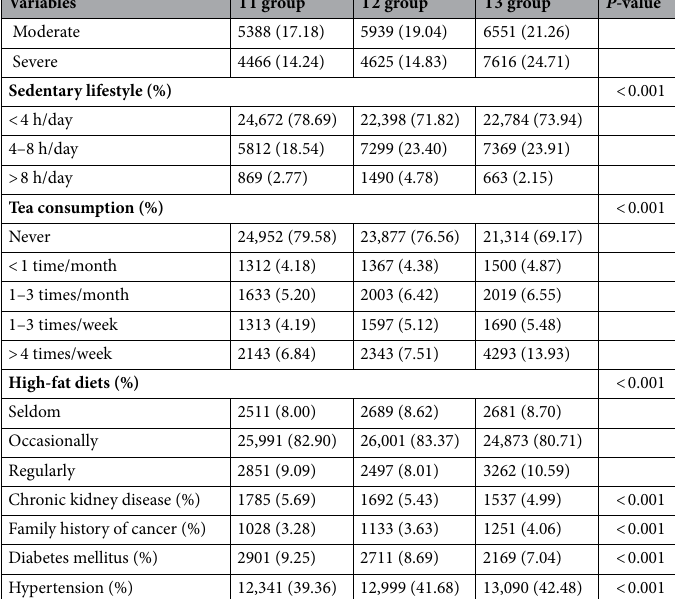
Table 1. Baseline characteristics of the participants stratified the tertiles of SUA. BMI body mass index, WC waist circumference, TC total cholesterol, CRP C-reactive protein, TG triglyceride, ALT alanine aminotransferase, TBIL total bilirubin, BMI body mass index.